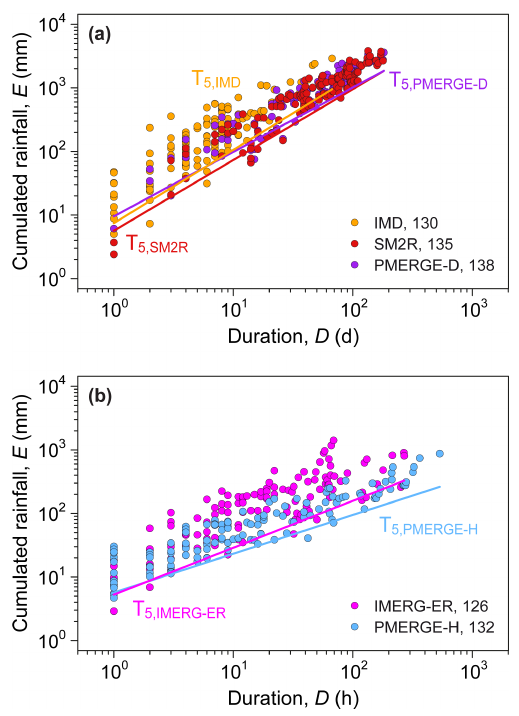
Figure 8. Rainfall ( D , E ) conditions and rainfall thresholds at 5% NEP level for (a) the daily resolution products IMD, SM2RASC and PMERGE-D and (b) the hourly resolution products IMERG and